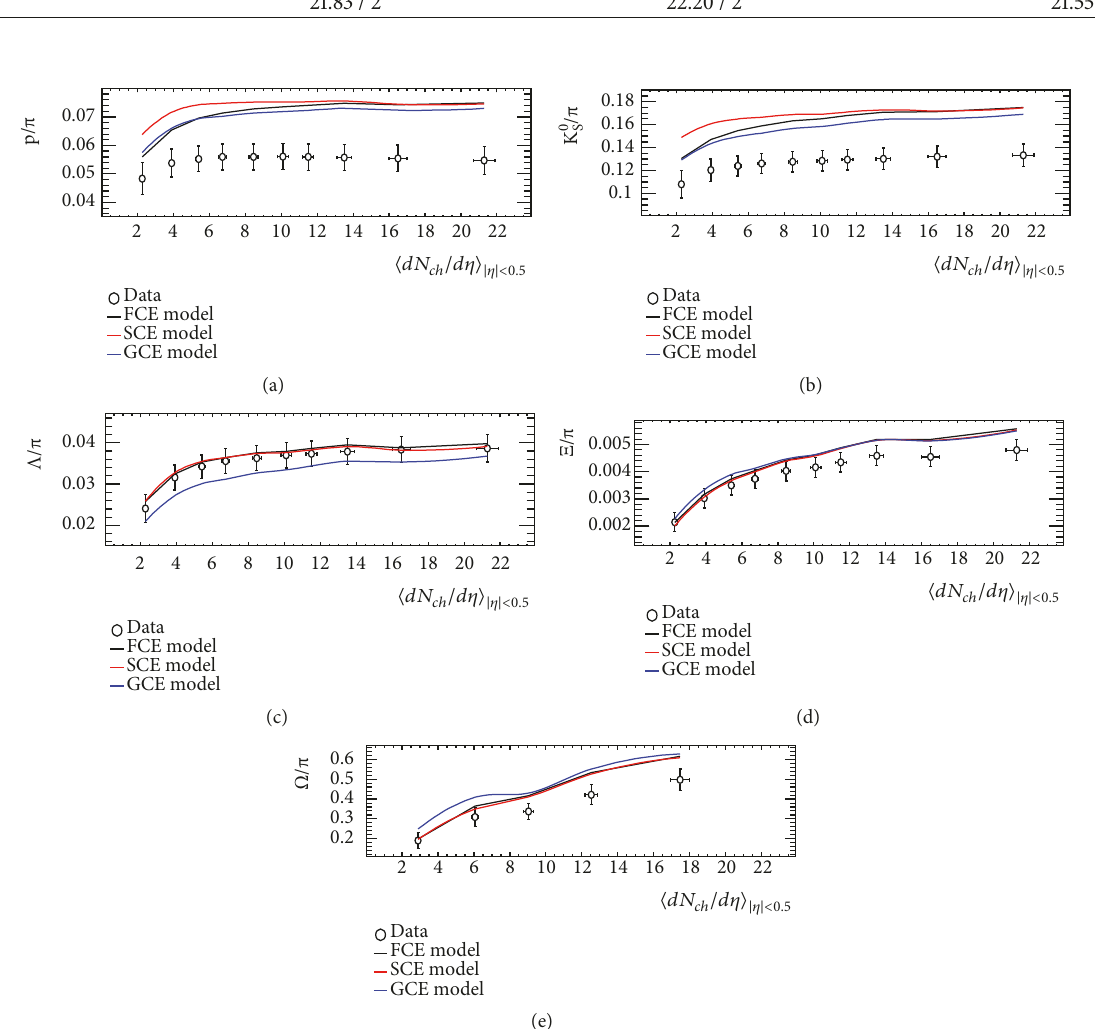
Figure 3: Ratios of particle to pion yields as a function of the final-state